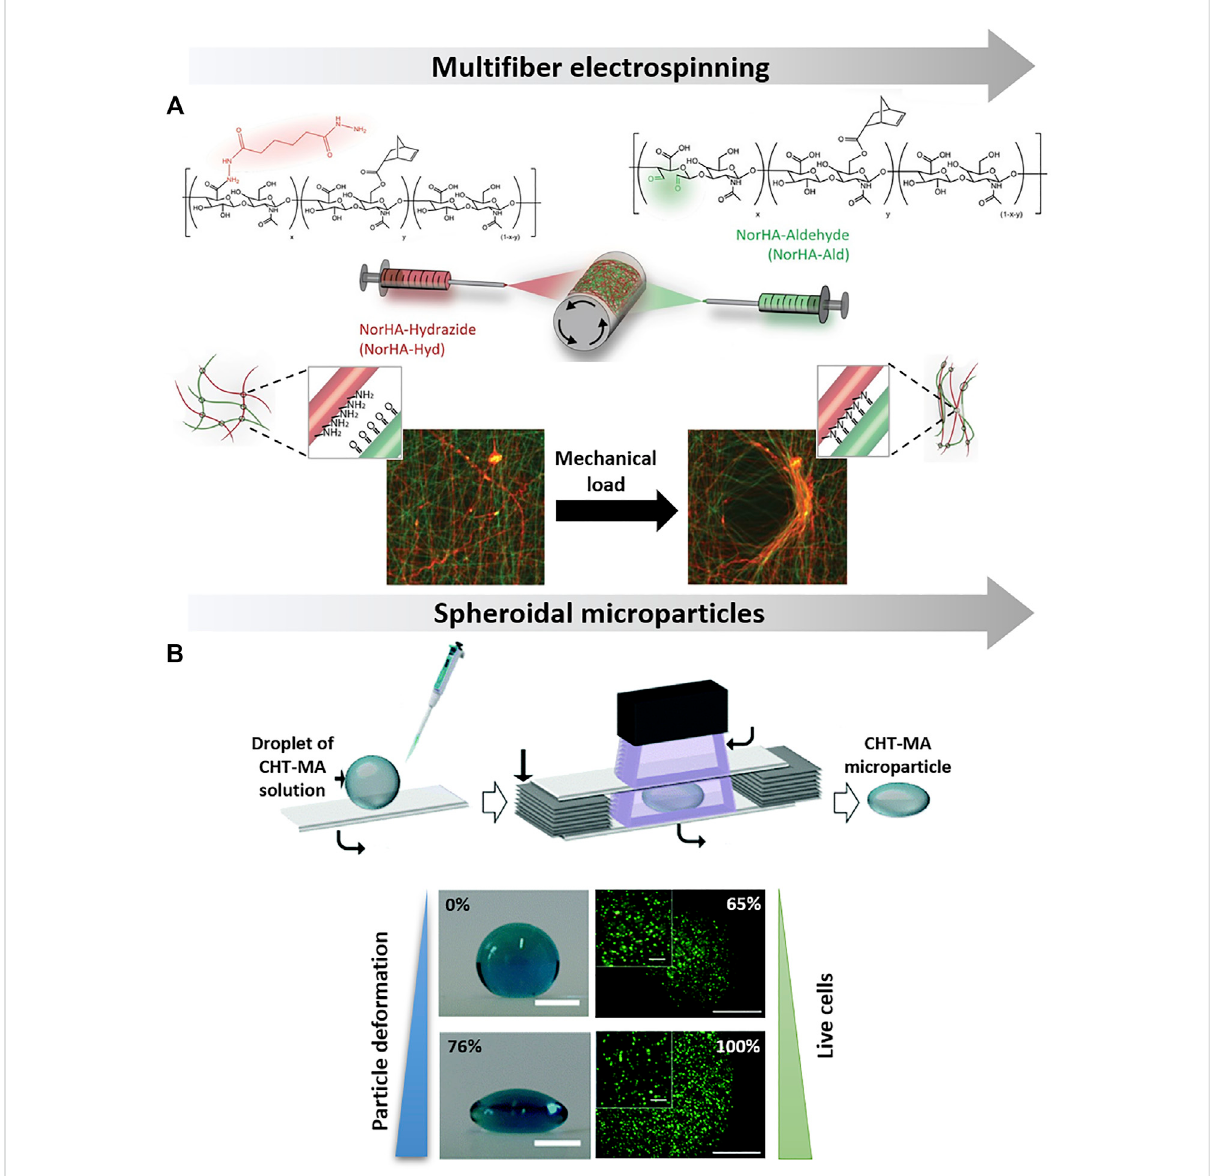
FIGURE 3 (A) Multi fi ber electrospinning to fabricate fi brous hydrogel networks with complementary chemical moieties (aldehyde and hydrazide groups) that form covalent bonds under mechanical. Adapted from ref (Davidson et al., 2020). with permission from John Wiley & Sons, Copyright 2019 WILEY-VCH Verlag GmbH & Co. KGaA, Weinheim; (B) Production of spheroid-like microgels by using superhydrophobic surfaces. Adapted from (Bjørge et al., 2018) with permission from American Chemical Society, Copyright